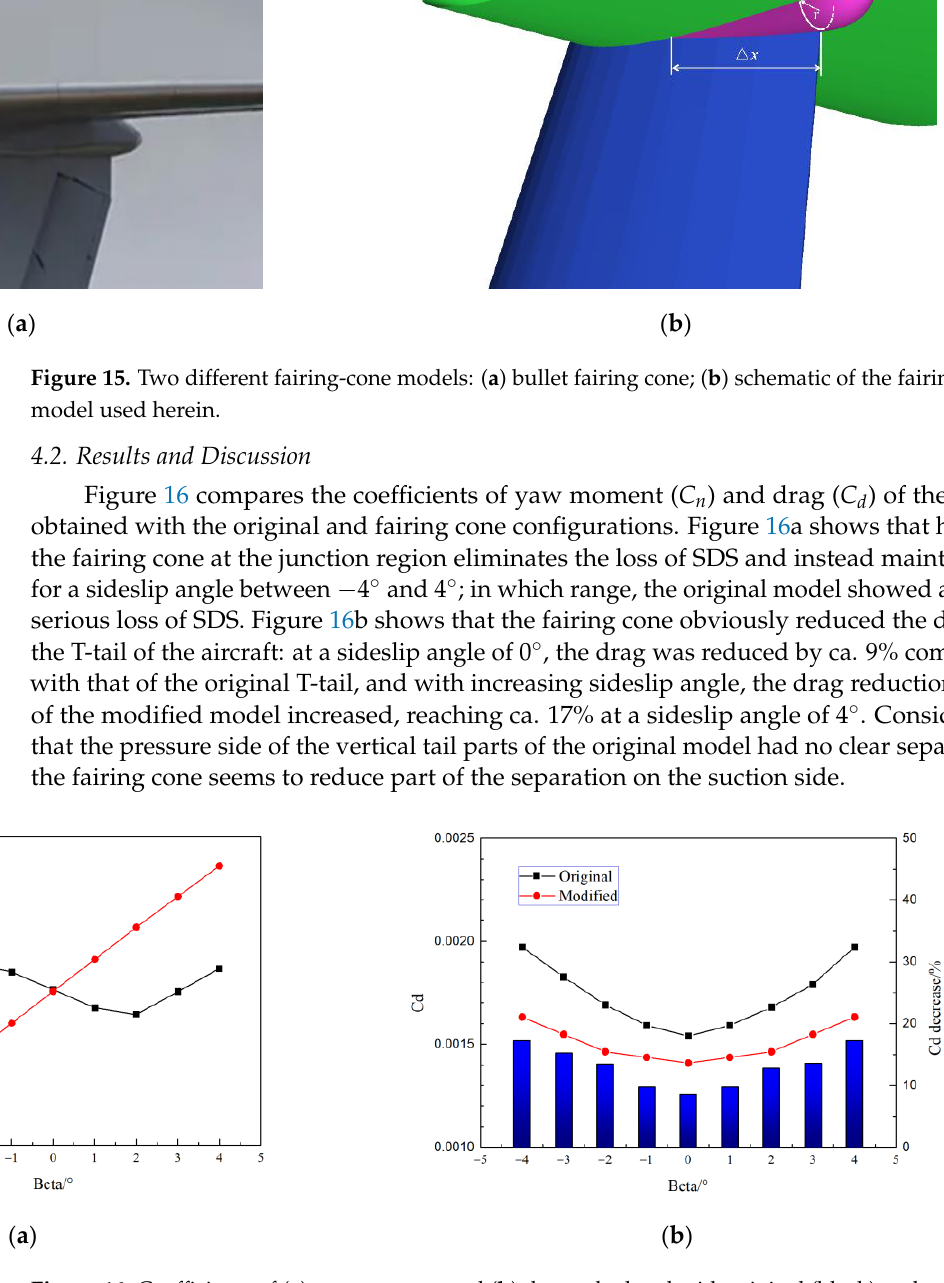
( c ) Figure 17. Streamlines and C p distribution on pressure side for modified model: β = ( a ) 0°, ( b ) 2°, and ( c ) 4°.